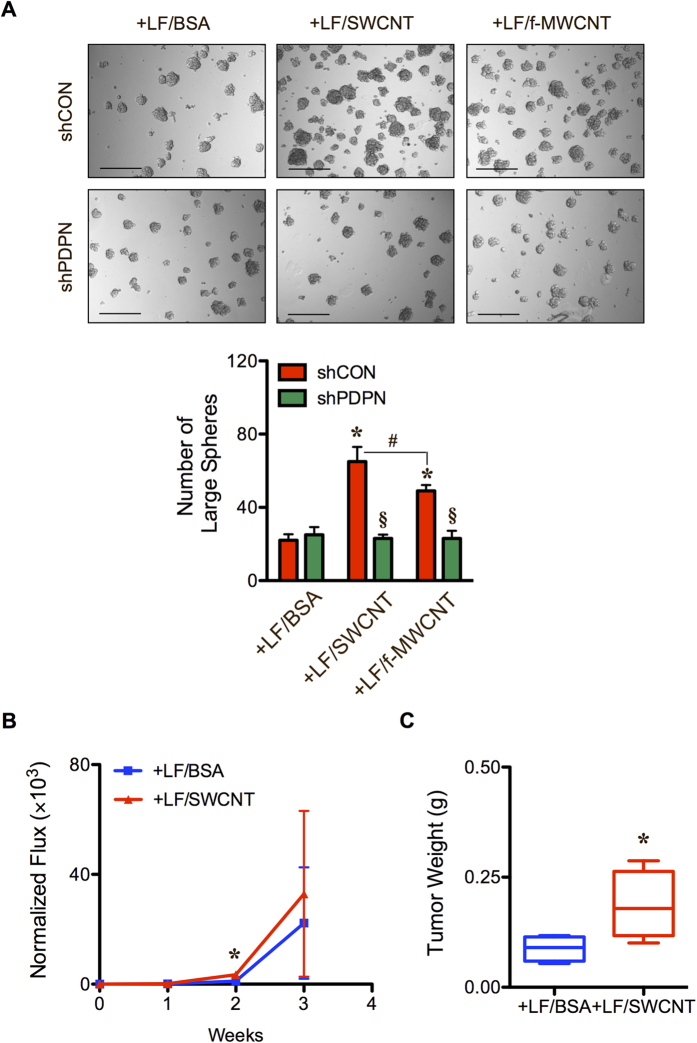
Carbon nanotube-induced cancer-associated fibroblast-like cells and podoplanin level are associated with tumorigenicity of carbon nanotube-transformed cells.(A) Carbon nanotube-induced cancer-associated shCON fibroblast-like cells (shCON-LF/SWCNT or LF/f-MWCNT) or carbon nanotube-treated shPDPN fibroblast-like cells (shPDPN-LF/SWCNT or LF/f-MWCNT) were co-cultured with SWCNT-transformed lung epithelial BEAS-2B/SWCNT cells (2:1 ratio), and tumor sphere formation was analyzed after 2 weeks of culture. Scale bar = 200 μm. (B) Carbon nanotube-induced cancer-associated fibroblast-like cells (LF/SWCNT) or vehicle-treated fibroblasts (LF/BSA) were co-injected with SWCNT-transformed lung epithelial BEAS-2B/SWNCT cells (2:1 ratio) into the left and right flanks of NSG mice. Tumor formation was monitored weekly by IVIS bioluminescence imaging. Normalization of tumor bioluminescence signals at various time points post-injection to their initial signals at day 0. (C) Subcutaneous tumors were dissected from mice bearing BEAS-2B/SWCNT and LF/SWCNT or LF/BSA, and were weighted at the end of experiments at 3 weeks post-injection. Data are mean ± SD (n = 4). *P < 0.05 vs H460 and shCON-LF/BSA group. §P < 0.05 vs CNT-treated shCON group. #P < 0.05 vs shCON-LF/SWCNT group.